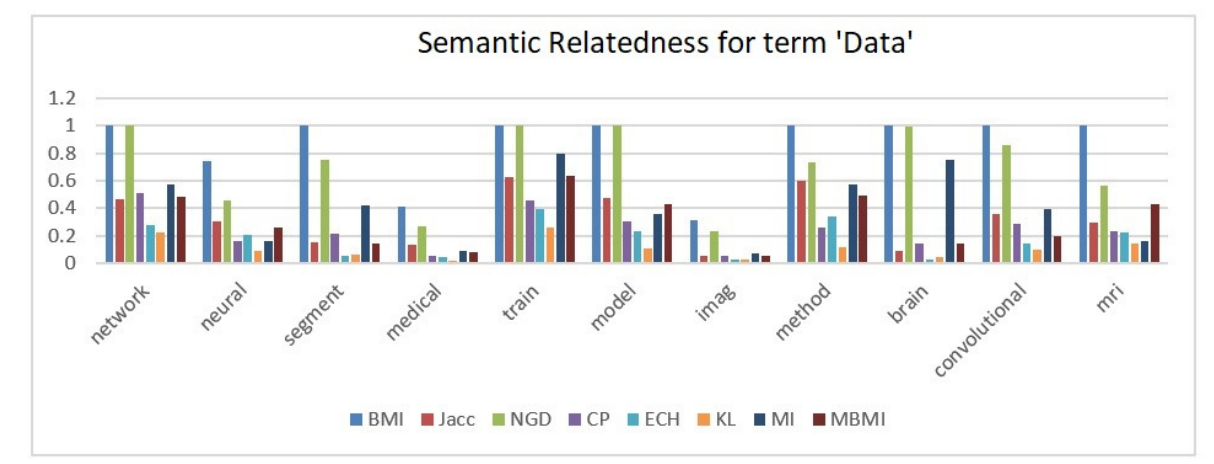
Figure 7. Semantic Similarity of term “DATA” with terms using different techniques